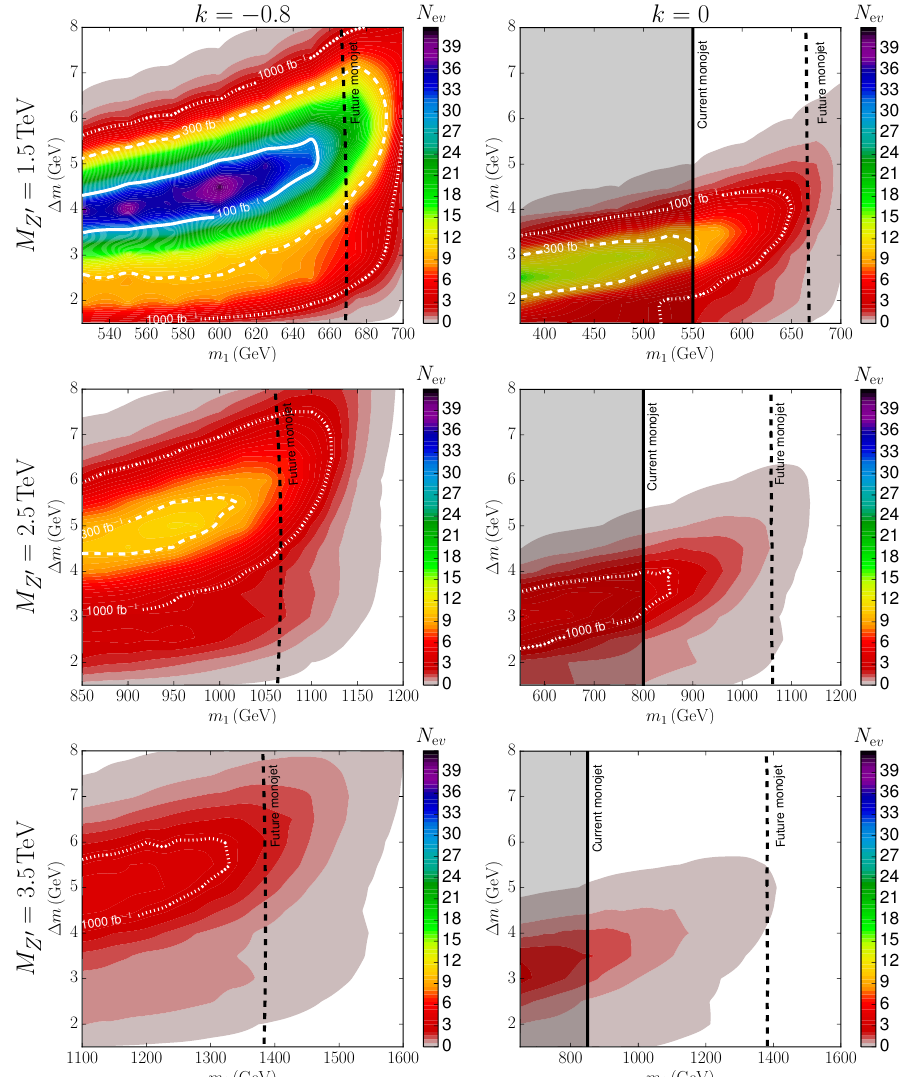
Figure 4 . Expected number of events and associated expected exclusion regions based on displaced vertex analysis at center of mass energy 13 TeV. The colourbar shows the expected number of events passing the displaced vertex selection criteria (see text for details) assuming = 1000 fb (cid:0) 1 . White L dotted, dashed, solid lines are prospective 95% exclusion regions at = 1000 ; 300 ; 100 fb (cid:0) 1 f g L f g respectively, corresponding to more than 3 events. Rows are for M Z 0 = 1 : 5 TeV (top), 2 : 5 TeV (center) and 3 : 5 TeV (bottom). Columns are for k = 0 : 8 (left) and k = 0 (right). Also shown are (cid:0) current and prospective monojet bounds (see section 4.1 for